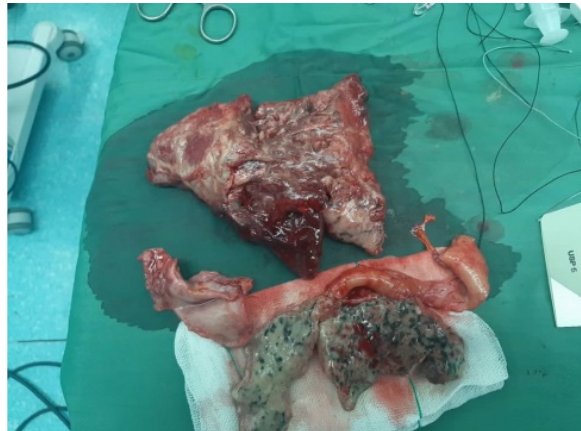
Figure 2. Lower lobe of the right lung